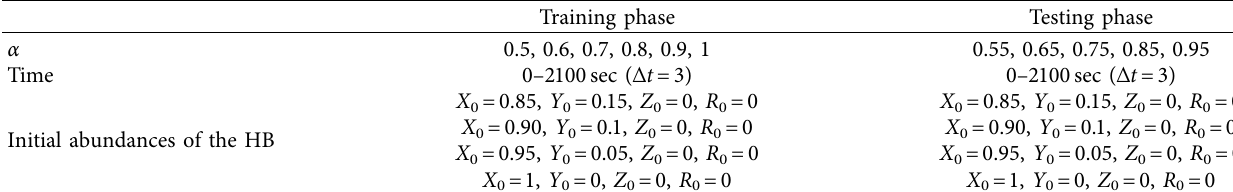
Table 1: Training and testing data for the helium burning network.